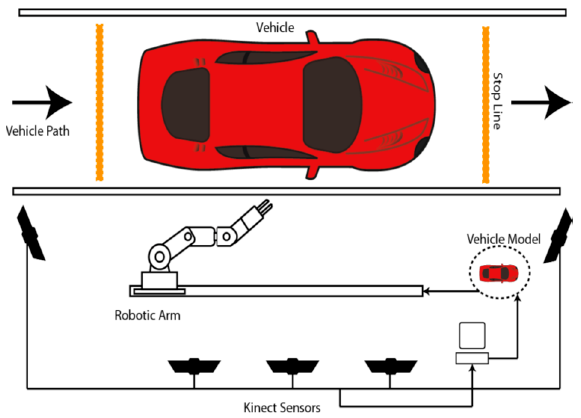
Figure 1. Conceptual automotive inspection system layout.